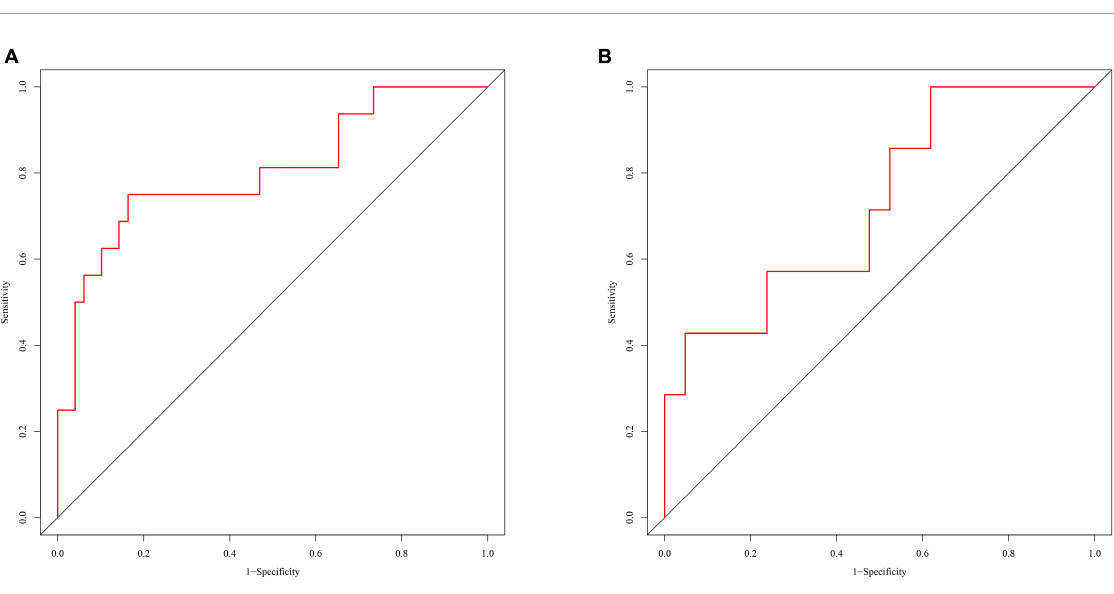
FIGURE3 Receiver operating characteristic curves of the radiomics signature in the training/validation cohort (A) and testing cohort (B)